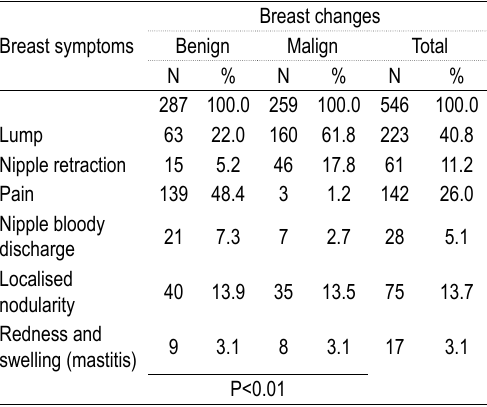
Table 1. breast symptoms in malign and benign